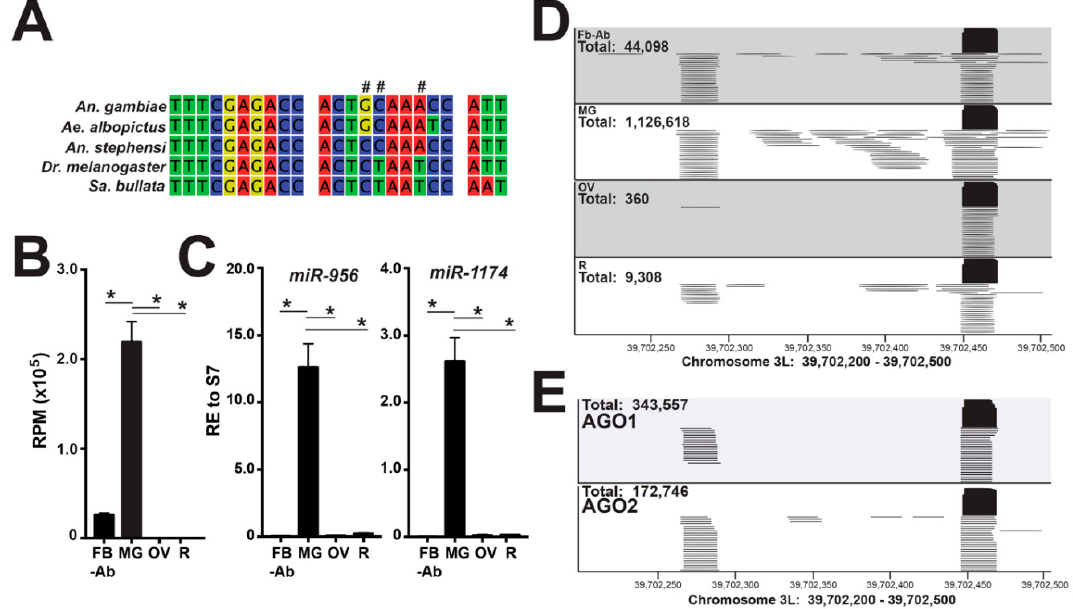
Figure 2. miR-956 expression dynamics across mosquito tissues. ( A ) miR-956 sequence alignment across dipterans; ‘#’ indicates a nucleotide mismatch between the A. gambiae and D. melanogaster miR-956 sequences. ( B ) Expression of miR-956 is significantly higher in the midgut (MG) over the fat body abdominal wall (FB-Ab), ovary (OV), and remaining head and thorax tissues (R). Reads per million (RPM) values are graphed as the average +/ − SEM from three biological replicates; ‘*’ indicates statistical significance by one-way analysis of variance (ANOVA) followed by Tukey’s multiple comparisons test, p < 0.0001. ( C ) The validation of the miR-956 enrichment in midgut tissues by RT- qPCR, values graphed as the average +/ − SEM from three biological replicates; ‘*’ indicates statistical